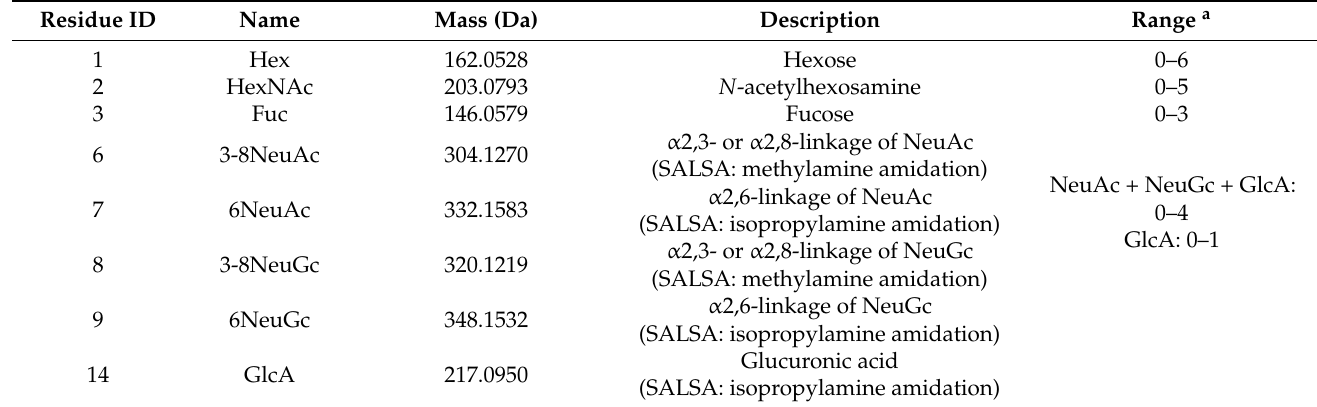
Table 1. Glycan residues in TAG used in this study. The methods used to modify carboxylic acid of sialic acid are shown in parenthesis. a Residue ranges are shown without the M3 core